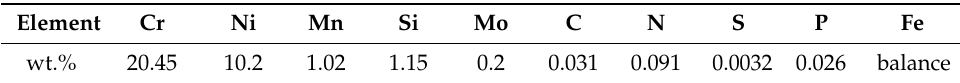
Table 1. Chemical composition of the studied steel.